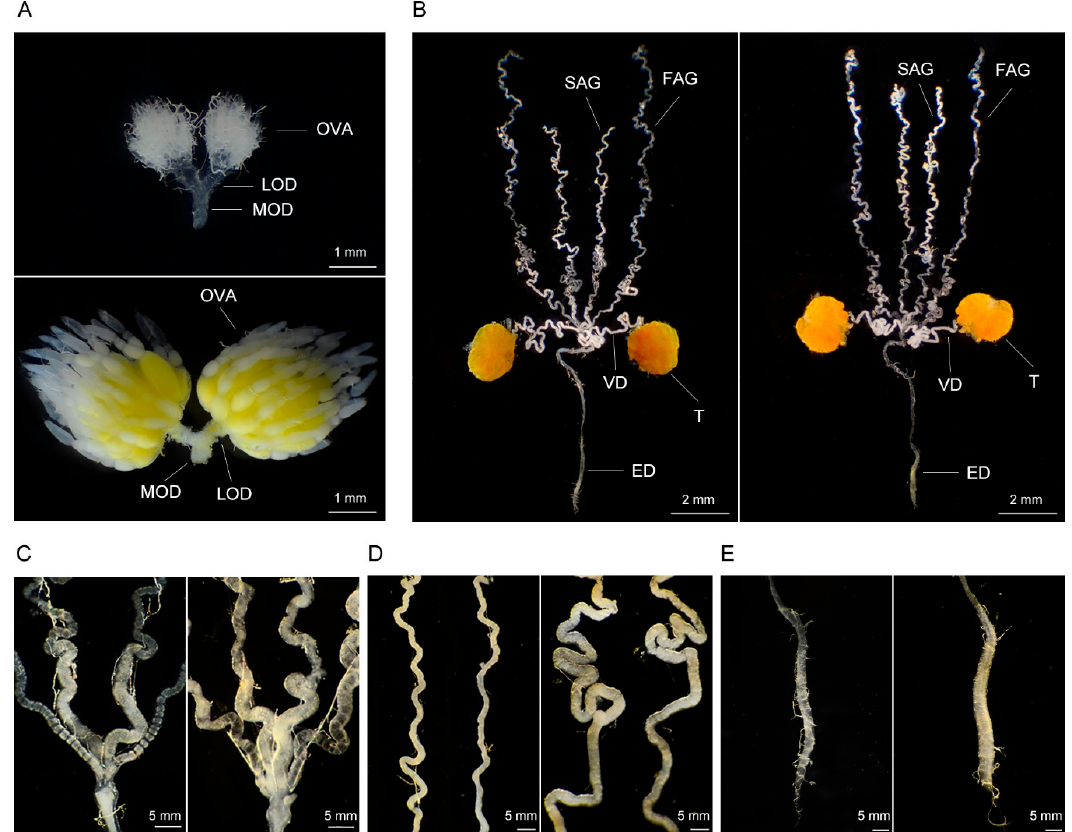
Figure 1. Morphological differences in the internal reproductive organs of diapause and reproductive adult H. axyridis . ( A ) Ovary of diapause (upper) and reproductive (lower) beetles; ( B ) male internal reproductive organs of diapause (left) and reproductive (right) beetles; ( C ) accessory gland of diapause (left) and reproductive (right) beetles; ( D ) vas deferens of diapause (left) and reproductive (right) beetles; ( E ) ejaculatory duct of diapause (left) and reproductive (right) beetles. OVA: Ovariole, LOD: Lateral oviduct, MOD: Median oviduct, FAG: First accessory gland, SAG: Second accessory gland, VD: Vas deferens, T: Testis, ED: Ejaculatory duct.